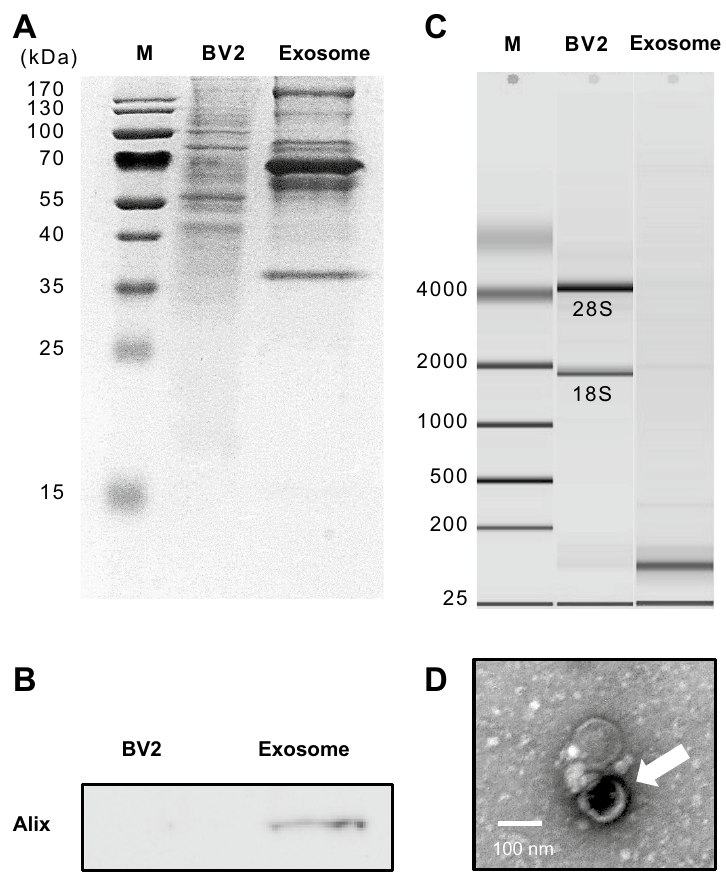
Figure 1. Characterization of BV2 cell-derived exosomes. ( A ) SDS-PAGE. Protein was isolated from either BV2 cells or BV2-derived exosomes. The pattern of proteins was different between the cell and exosomes. ( B ) Western blot analysis of exosome marker (Alix). ( C ) Purified RNA from BV2 cells and BV2-derived exosomes were evaluated using a Bioanalyzer. As a result, the 18S and 28S ribosomal subunits in BV2 cells were rarely observed in the RNA of exosomes. ( D ) Transmission electron microscopy showing an exosome isolated from BV2 cells stained negatively with 2% uranyl acetate. The exosomes were approximately 60–150 nm in size with a cup-shaped structure (Song and Jung, unpublished